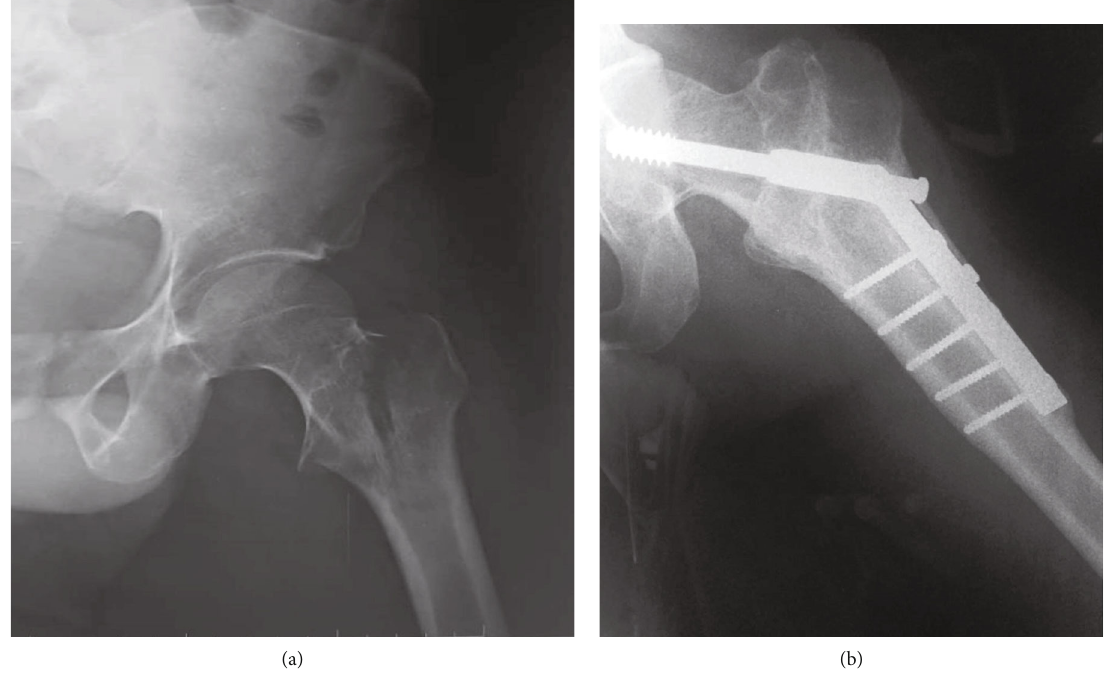
Figure 5: X-rays of patient 5. (a) Pertrochanteric fracture of the left hip class 31A1.2 according to AO/OTA. (b) Osteosynthesis by